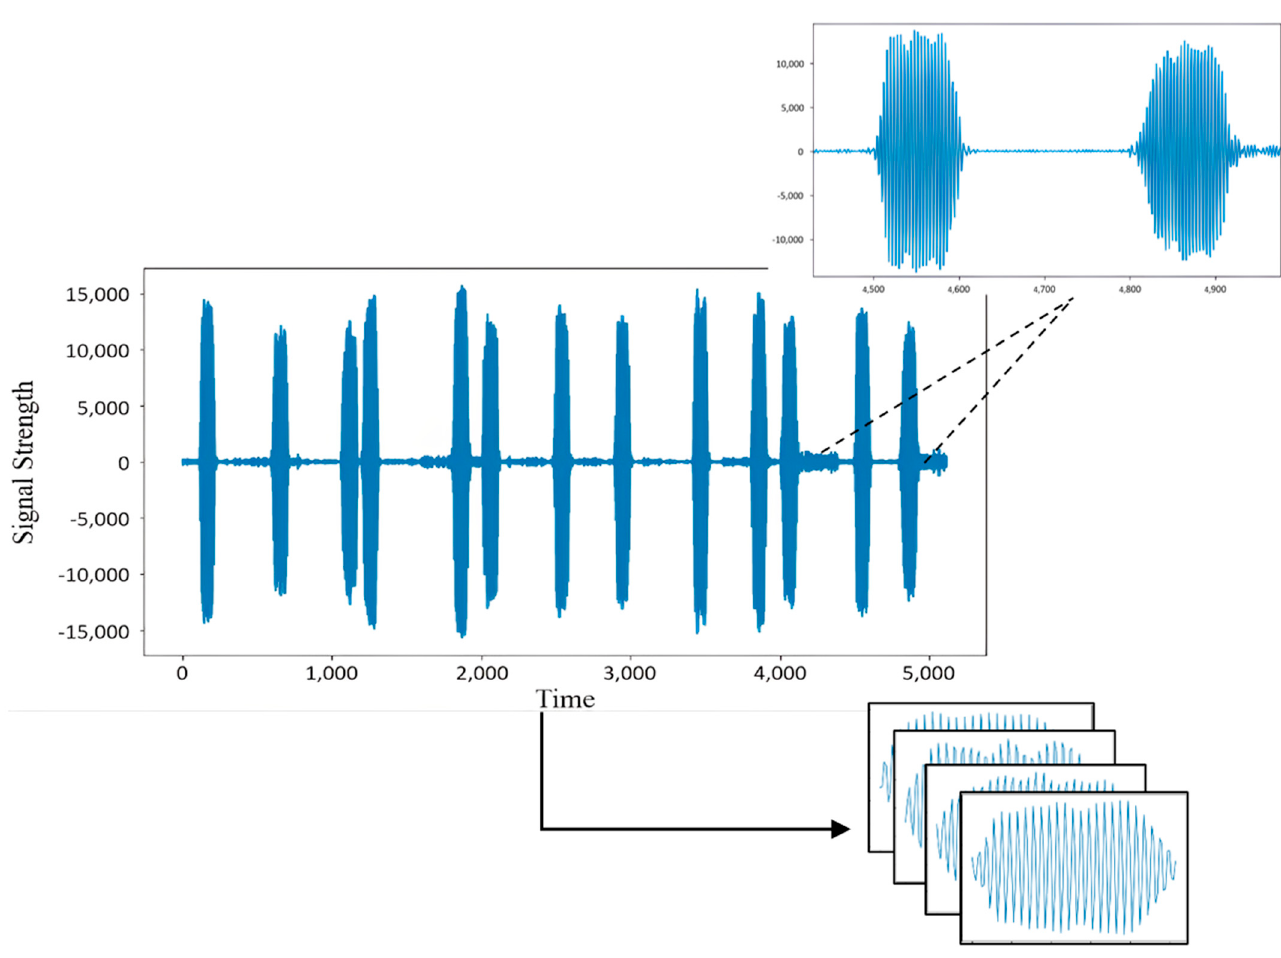
Figure 1. Radar signal dataset.